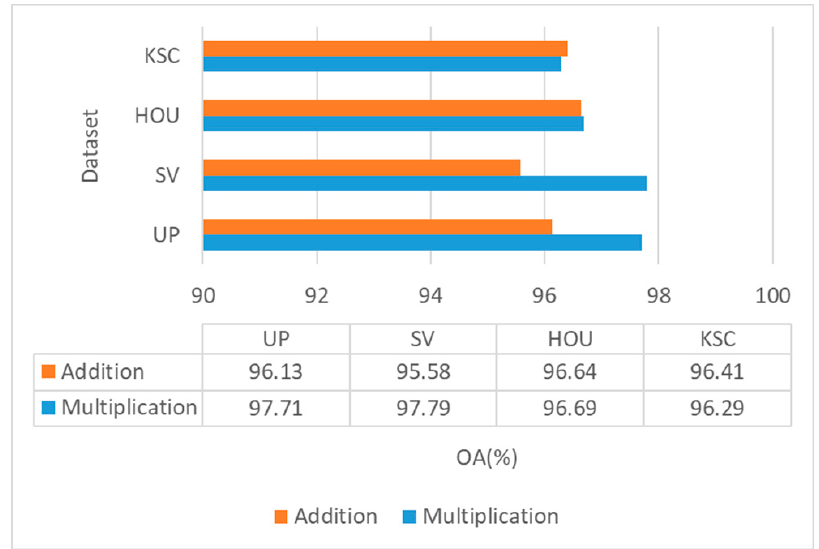
Figure 18. OAs (%) with different fusion functions for the DAM.